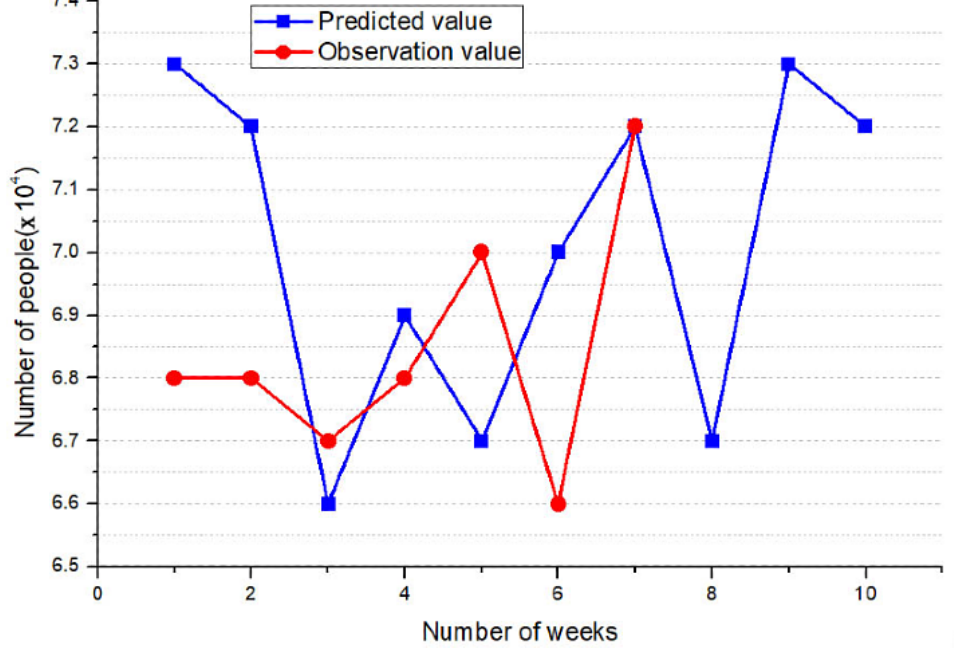
Table 3. Comparison of outpatient volume prediction